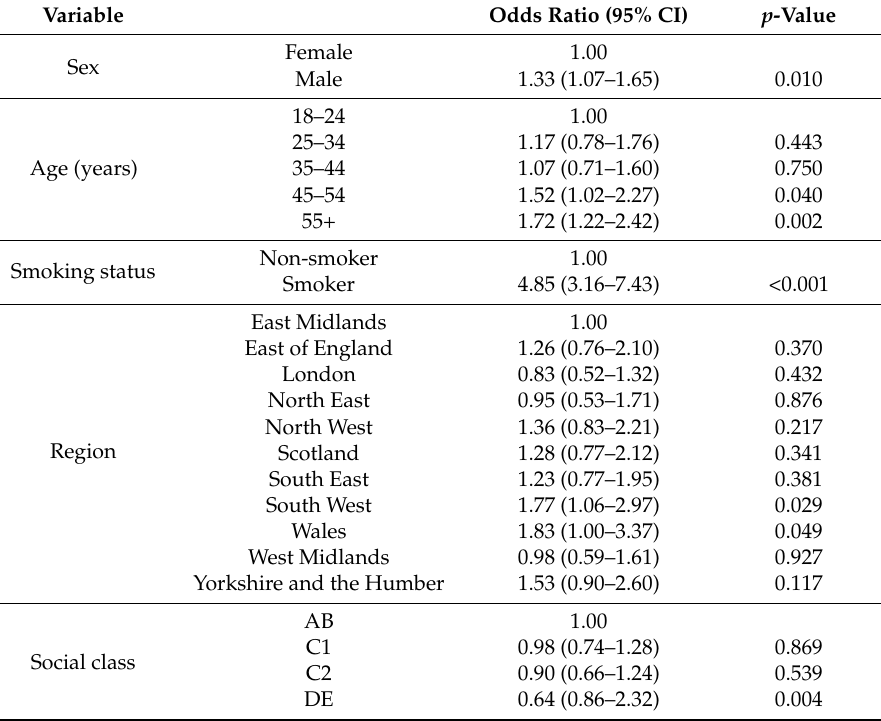
Table 3. Determinants of awareness of plain packaging.